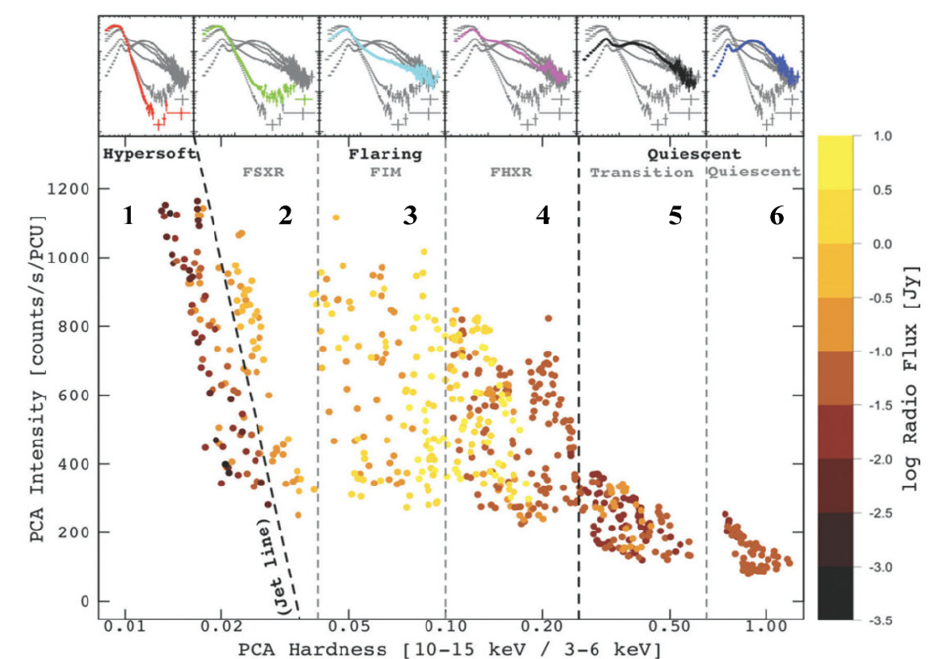
Figure 9. Diagram of states adopted from Figure 3 of [11]: The behavior of Cyg X-3 in the radio (Ryle, GBI, RATAN-600) and X-ray (RXTE) bands were analized and six states, depending on the ratio of the intensities in these ranges and the spectral characteristics in the X-ray energy band were